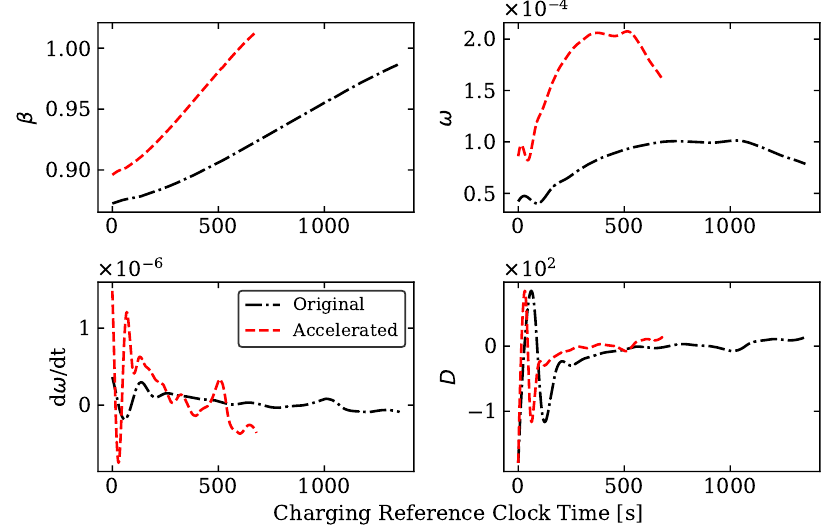
Figure 19. Comparison of charging mode at the outlet location, phase